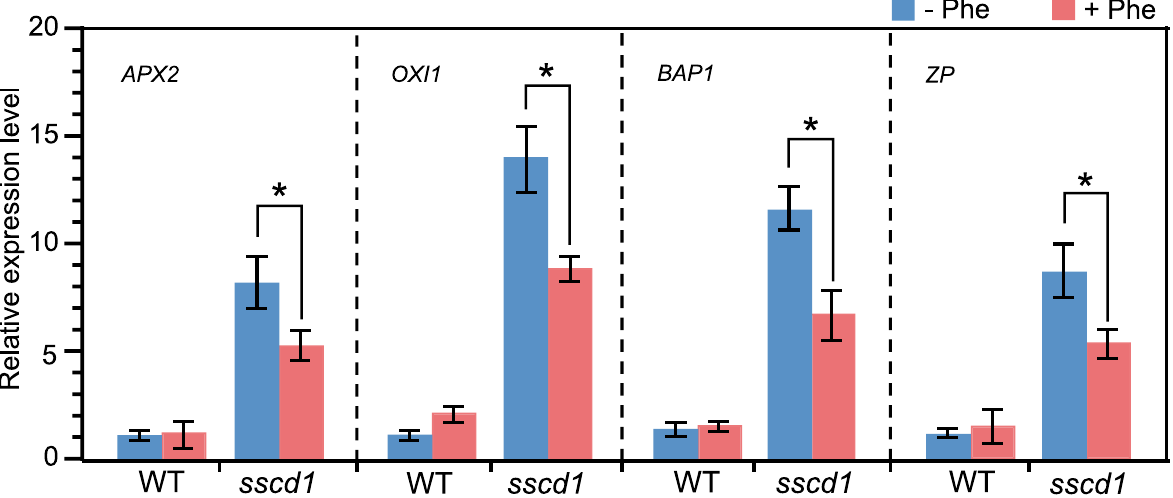
Figure 2. Expression of ROS marker genes in sscd1 was down-regulated by treatment with Phe. Relative expression levels of APX2, OXI1, BAP1 and ZP in WT and sscd1 seedlings which were first grown in MS medium under LD for 7 days and transplanted to MS medium added without (−) or with (+) 2 mM Phe under LD for an additional 7-day growth, and then transferred to SD for a 3-d growth. ACTIN2 expression was used as the internal control. Each value is the mean of three independent biological replicates ± standard deviation. An asterisk represents the significance of differences (two-tailed Student’s t-test) at the level of P < 0.05. WT wild type, Col-0; Phe phenylalanine; LD long day; SD short day.